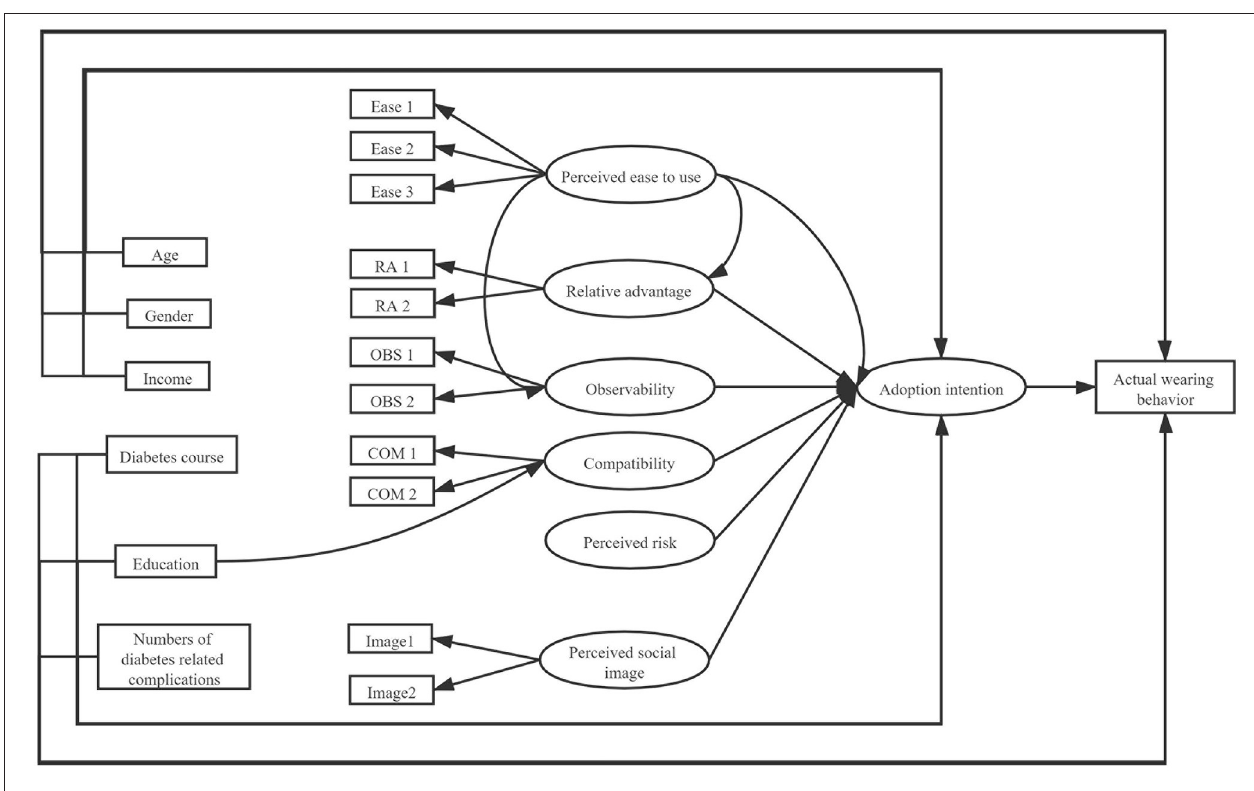
FIGURE 1 | Proposed hypothesis in the current